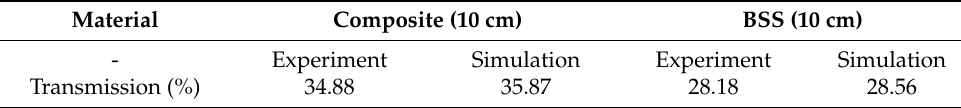
Figure 13. A comparison of the experimental and simulation results of two materials. Table 3. The simulation and experimental results of two materials at 10 cm.